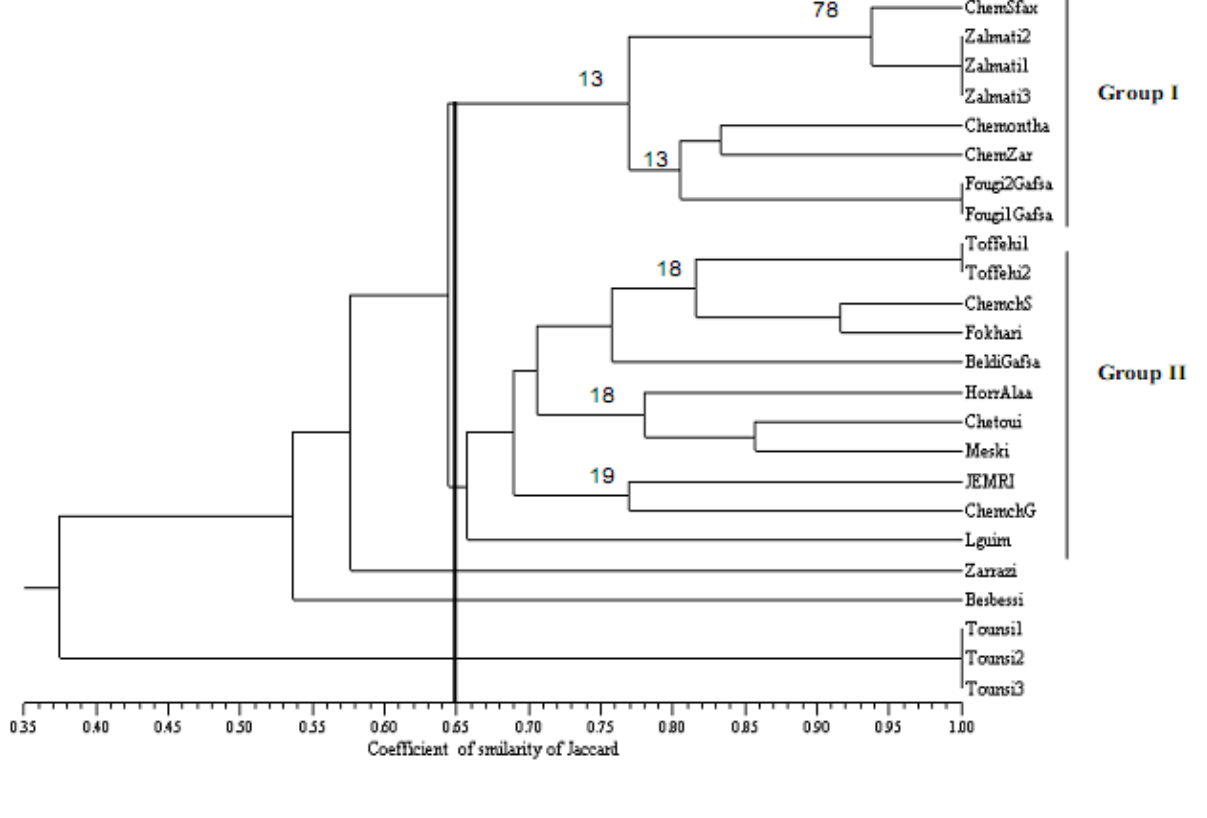
Figure 2. Dendrogram of 24 olive cultivars generated by cluster analysis using Jaccard similarity coefficients from single nucleotide polymorphism markers and UPGMA method. Number are bootstrap values estimated over 100 replicates using PHYLIP